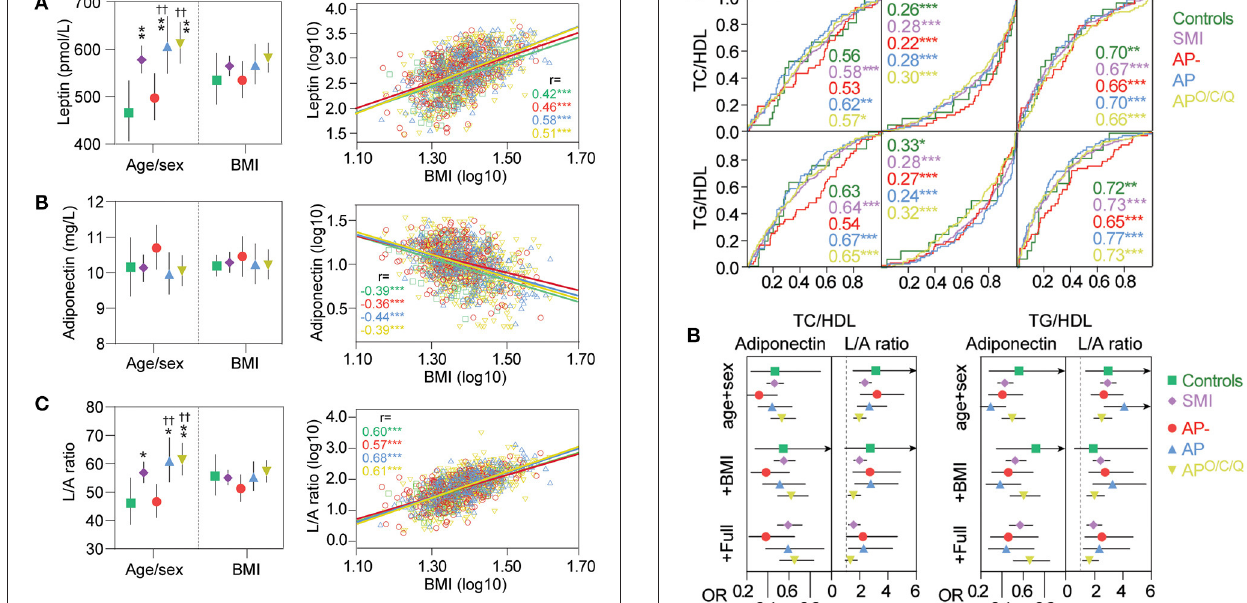
FIGURE 2 | Association between Adiponectin and the L/A ratio and atherogenic risk. (A) Association between Adiponectin or the L/A ratio, and having a TC/HDL or TG/HDL above threshold levels as assessed by the area under the receiver-operating characteristics curve (ROC). Numbers indicate the AUC in the different groups. * p < 0.05 ** p < 0.01 *** p < 0.001. (B) Association between adiponectin and L/A levels and cardiovascular risk (TC/HDL, TG/HDL) using logistic regression with adjustment levels for a. Age and sex b. a + BMI c. b + C-reactive protein (CRP), insulin resistance (HOMA-IR), smoking, and anti-psychotic treatment dose (DDD), duration of illness, mood stabilizers (DDD), duration of AP treatment. Odds ratios (OR) are expressed as log-transformed per SD change in marker. Odds ratios with 95% Confidence interval are given in Supplementary Tables 2, 3